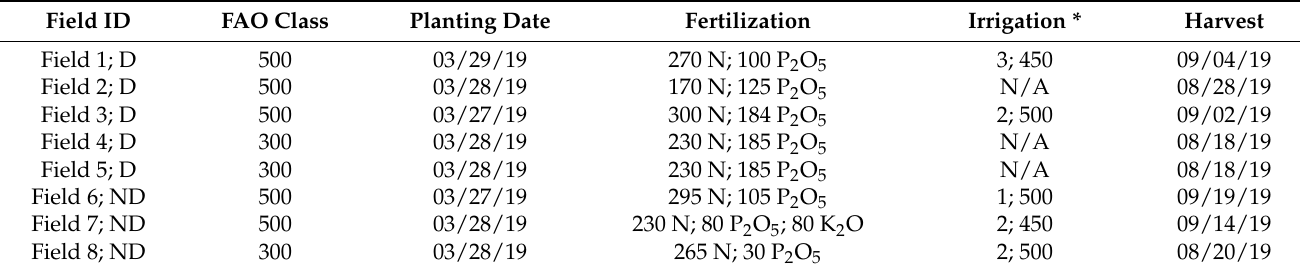
Figure 2. Daily maximum (black line), minimum (red line) air temperature, reference DSSAT evapotranspiration (gray line), and rainfall (blue vertical bars) during the 2019 growing season from the Agenzia Regionale per la Prevenzione e Protezione Ambientale del Veneto (ARPAV;